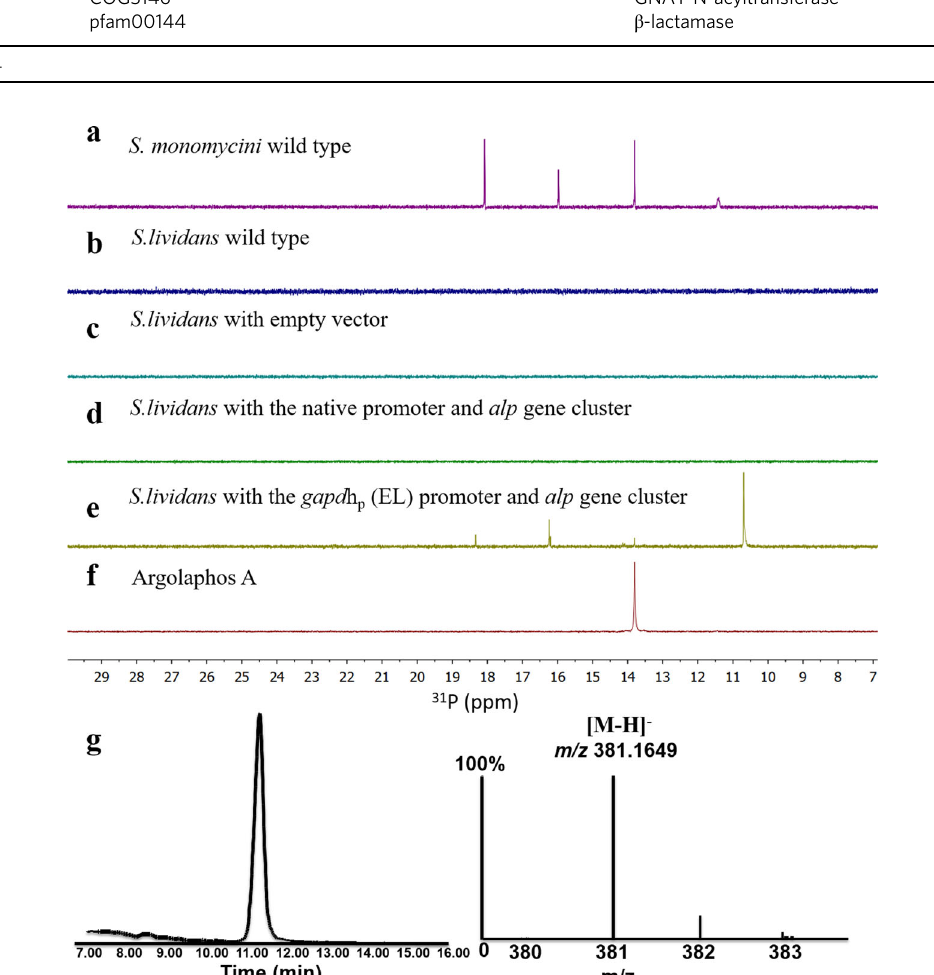
Fig. 3 Analysis of the full-cluster integrated strain S. lividans 66. a 31 P NMR spectrum of the culture extracts from S. monomycini NRRL B-24309. b 31 P NMR spectrum of the wild-type S. lividans 66. c 31 P NMR spectrum of S. lividans 66 transformed with empty vector. d 31 P NMR spectrum of S. lividans 66 transformed with the native promoter and alp gene cluster. e 31 P NMR spectrum of S. lividans 66 transformed with the gapdh p ( E. lenta , EL) promoter and alp gene cluster. f 31 P NMR spectrum of argolaphos A standard. g Extracted ion current chromatogram of the culture extracts from S. lividans 66 transformed with the gapdh p ( E. lenta , EL) promoter and alp gene